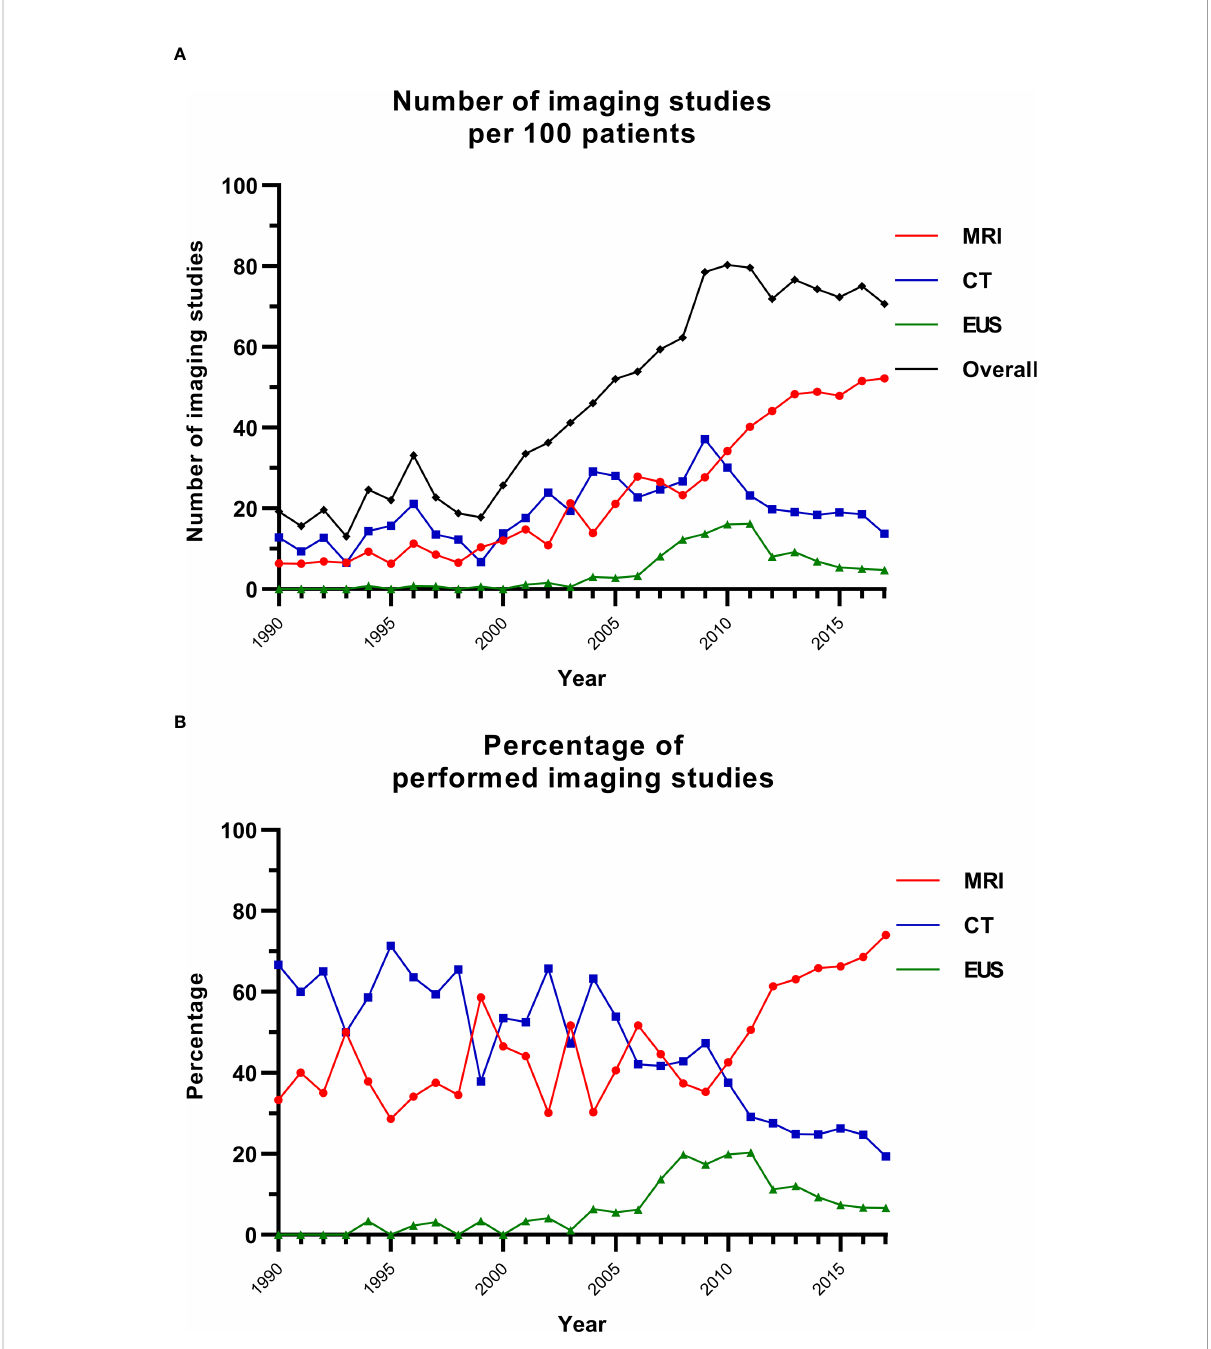
standard in 6 patients (5.5%) with a PanNET in the pancreatic head and 16 patients (14.7%) with a PanNET in body/tail. Contingency tables (Table 3) show that MRI was true positive for 15 out of 15 pancreatic head tumors and 21 out of 23 pancreatic body/tail tumors, indicating a PPV